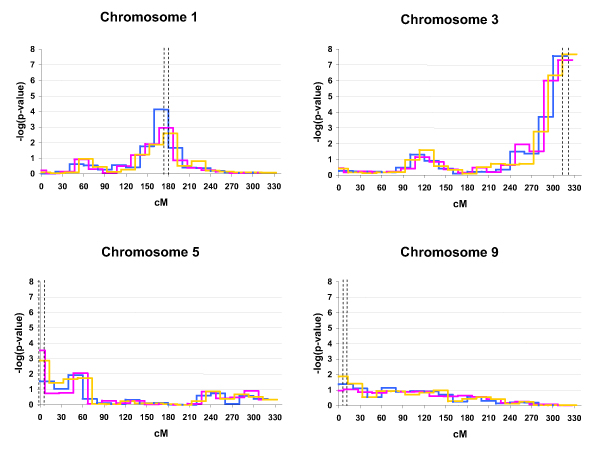
Graphic representation of the minimum regions of maximum significance (MRMS) for those chromosomes with GSMA-MRMS values < 0.01. The dashed vertical lines indicate the 6–7 cM MRMS region for chromosomes 1, 3, 5, and 9 and therefore the regions targeted for SNP packet purchasing for fine-mapping.